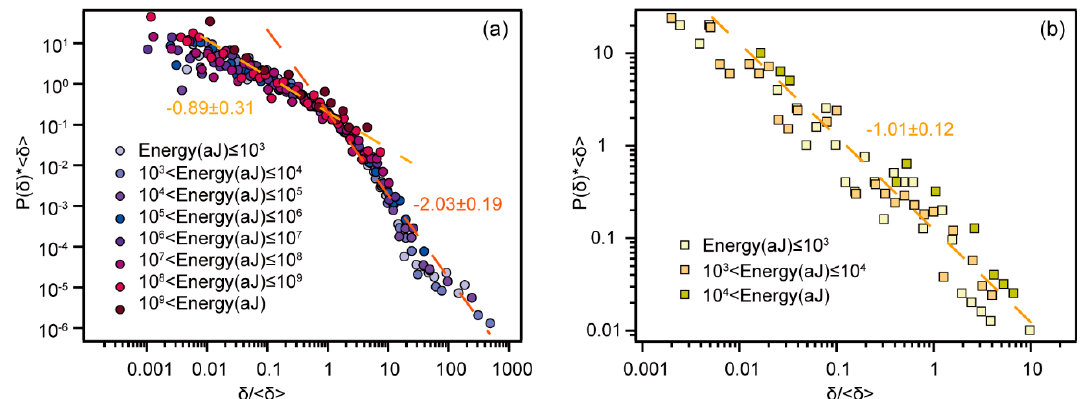
Figure 5. Probability density distribution of waiting time for ( a ) non-tectonic and ( b ) tectonic coal. The waiting time distribution of non-tectonic coal follows the typical brittle fracture’s double power law behavior, while the waiting time distribution of tectonic coal shows the single power law.